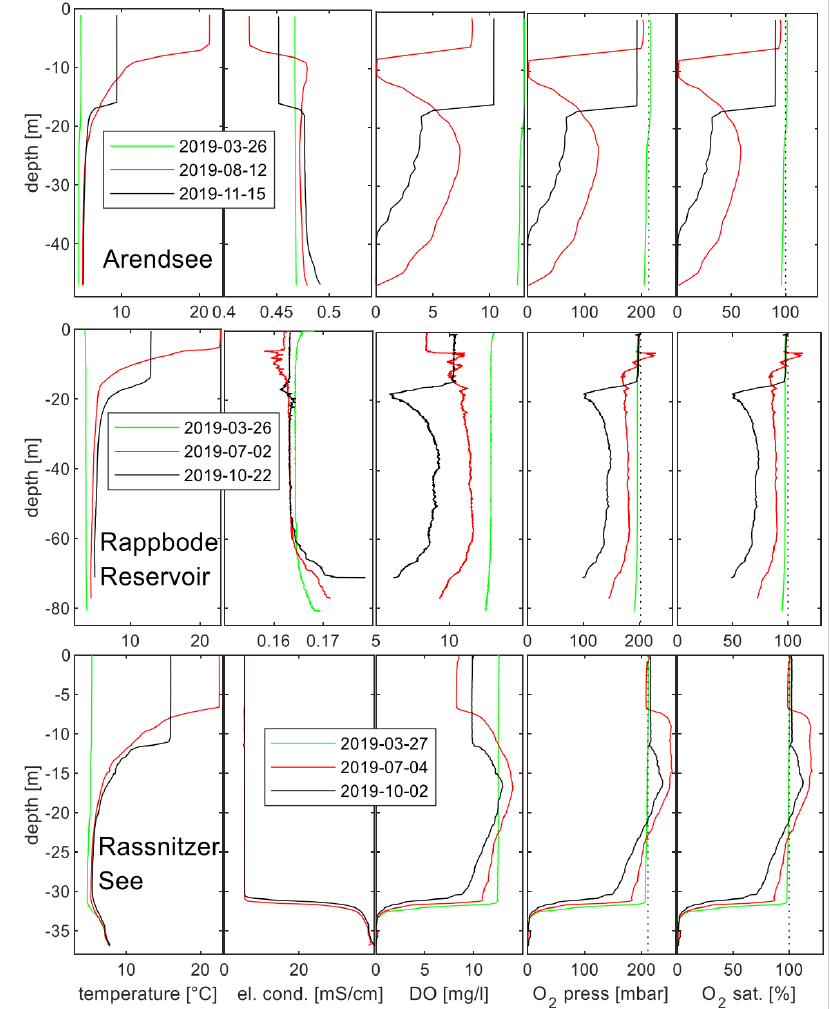
Figure 2. Profiles measured in Arendsee, Rappbode Reservoir, Rassnitzer See (all located in Saxony- Anhalt, Germany) on three sampling dates (green: spring, red; summer, black: autumn) in 2019: temperature, electrical conductivity, dissolved oxygen concentration, oxygen gas pressure (dotted line: atmospheric gas pressure at lake surface), oxygen saturation (dotted line: 100%